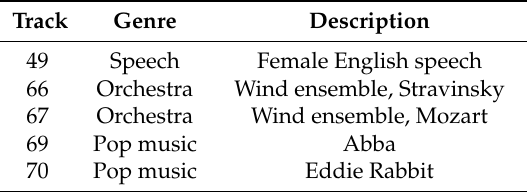
Figure 11. Experimental setup for evaluating the perceived directions. Table 1. Detailed information on five audio clips used for the evaluation of perceived